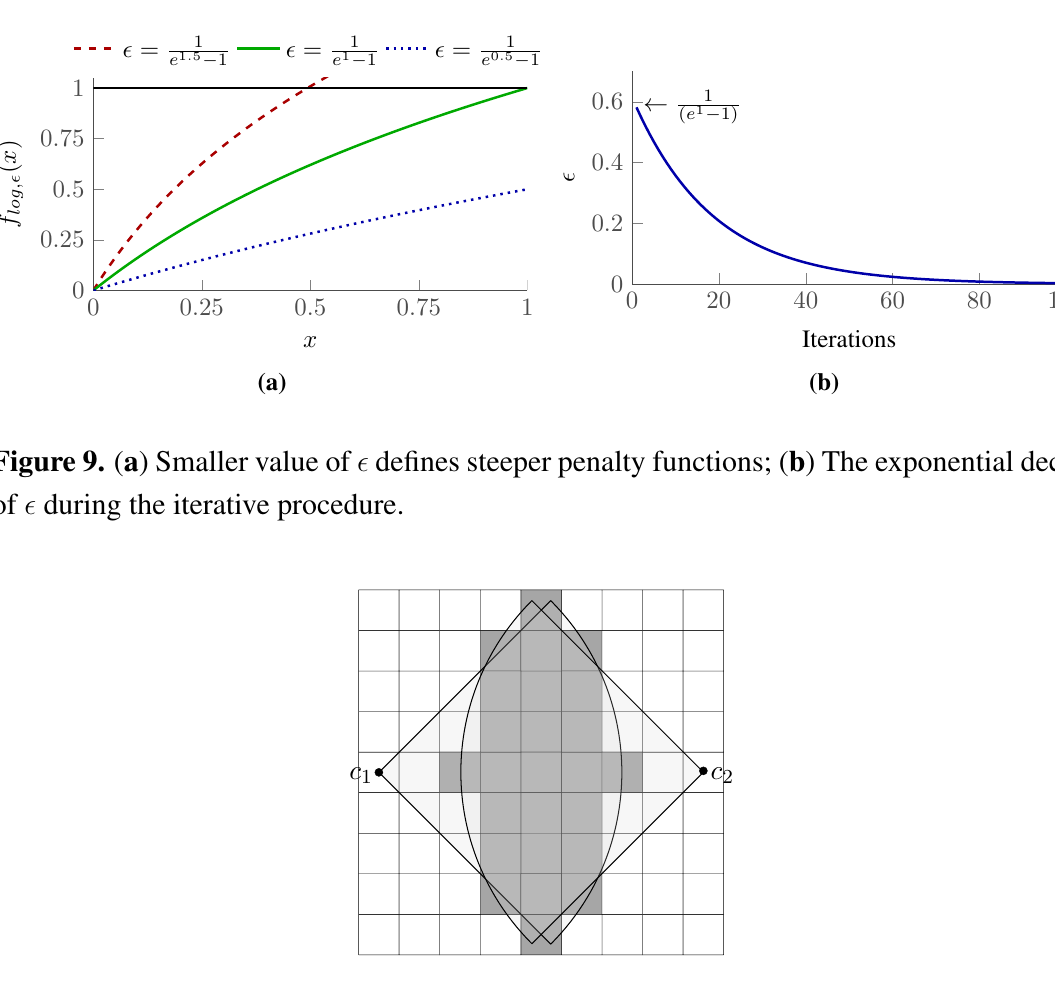
Figure 10. The sensing configurations c under the overlapping field of view are indicated in gray. Assuming that the remaining visible cells of both configurations, indicated in white under the coverage window, are partially (50%) observed by another configuration(s) in the solution. The c the solution vector and any subsequent iteration does not improve the